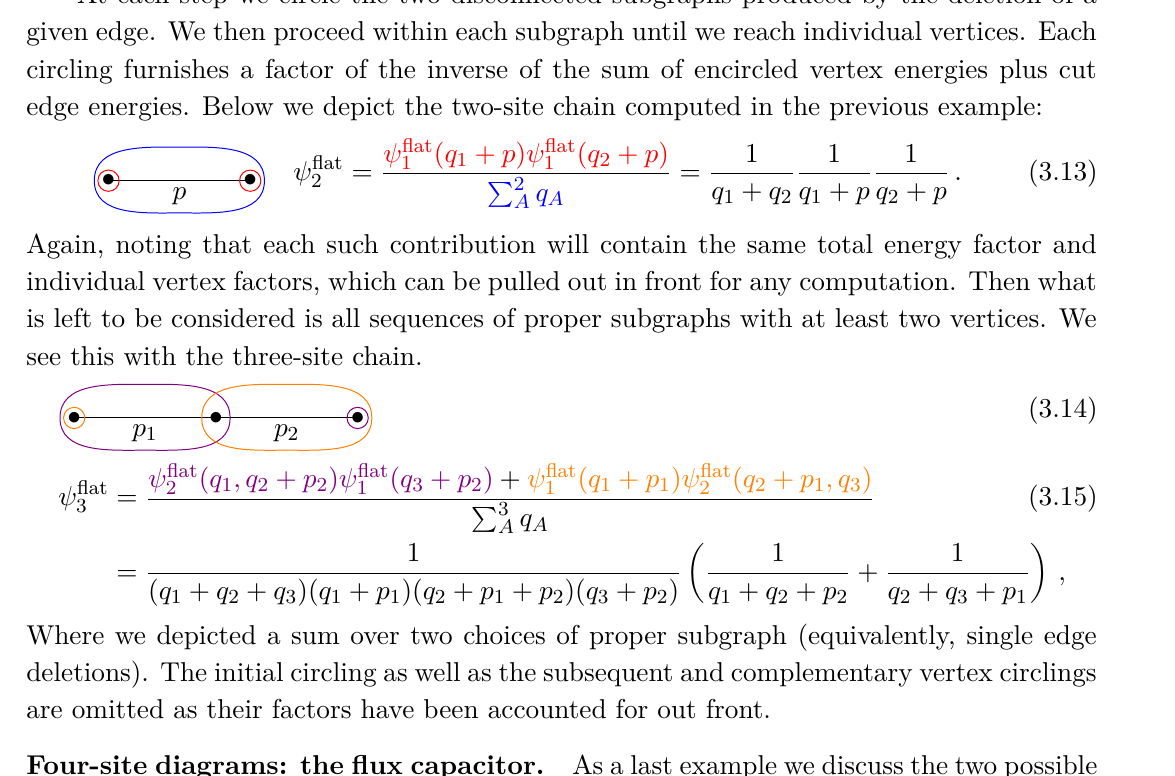
associated A of each internal line (edge) m = 1 , 2 , 3 m